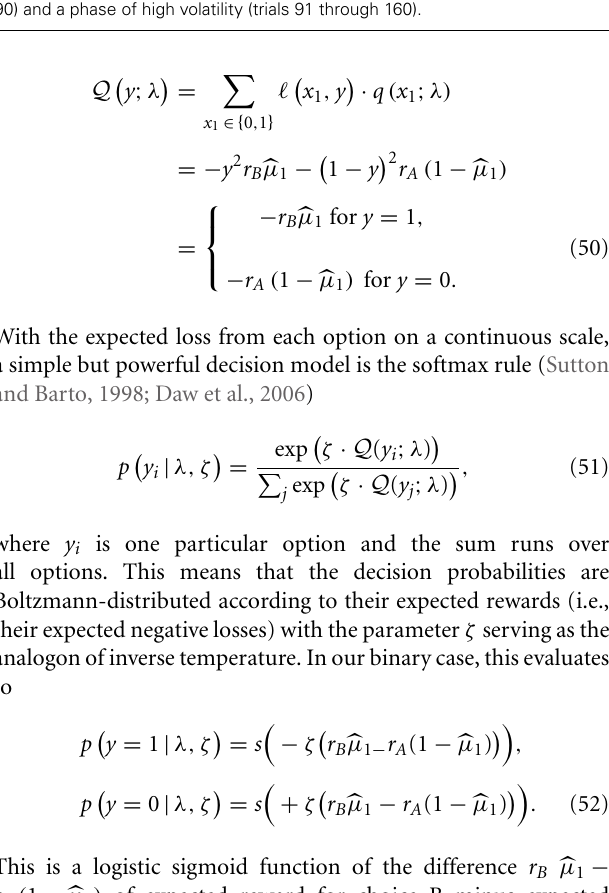
FIGURE 6 | One-armed bandit task. Participants were engaged in a simple decision-making task. Each trial consisted of four phases. (i) Cue phase. Two cards and their costs were displayed. (ii) Decision phase. Once the subject had made a decision, the chosen card was highlighted. (iii) Outcome phase. The outcome of a decision was displayed, and added to the score bar only if